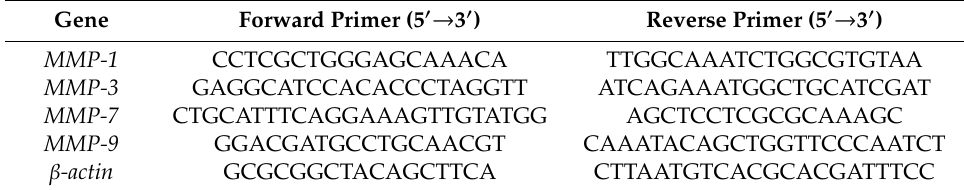
Table 2. The primers used for real-time